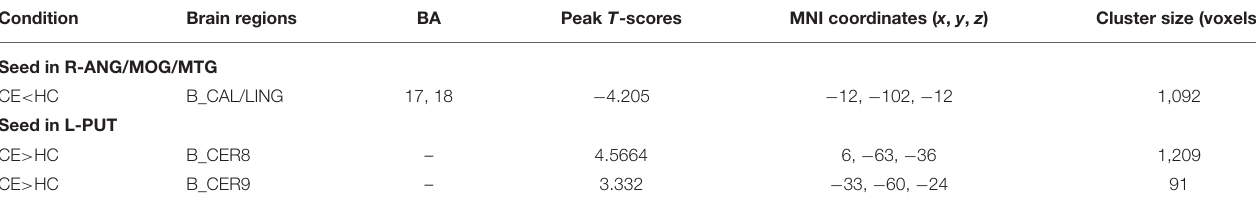
TABLE 3 | Different functional connectivity (FC) values between the two groups. Condition Brain regions Cluster size (voxels)